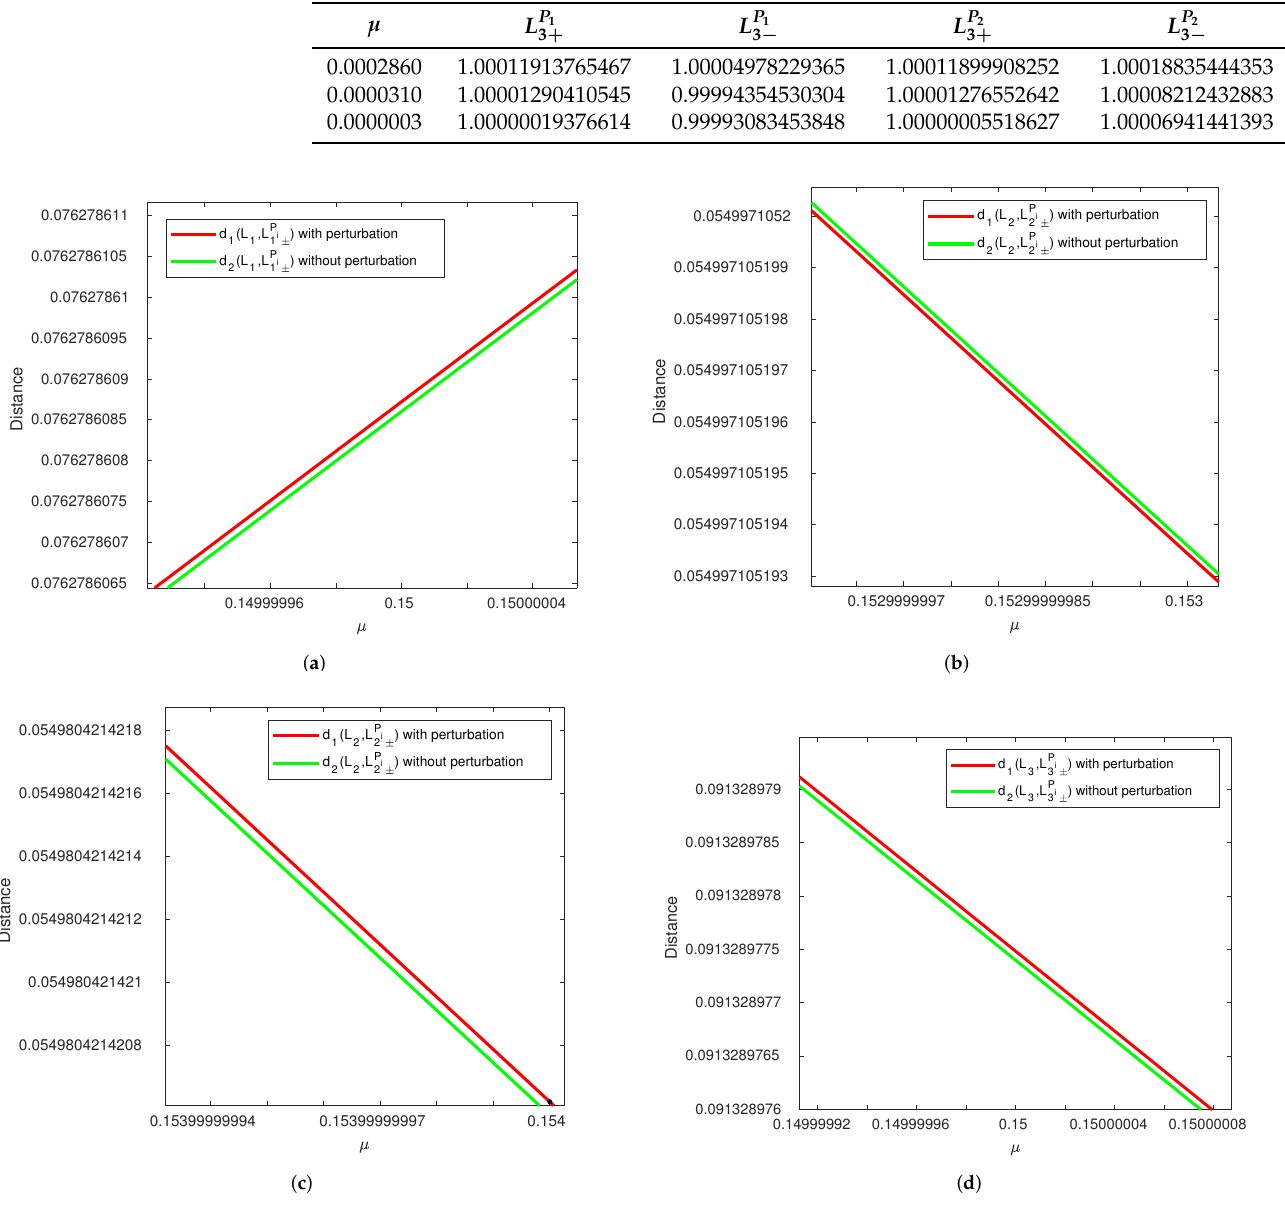
Figure 4. Comparison of distance versus µ between perturbed (red line) and unperturbed (green line) collinear equilibrium points in R2+2BP. ( a ) For L 1 equilibrium point. ( b ) For L 2 equilibrium point. ( c ) For L 2 equilibrium point. ( d ) For L 3 equilibrium